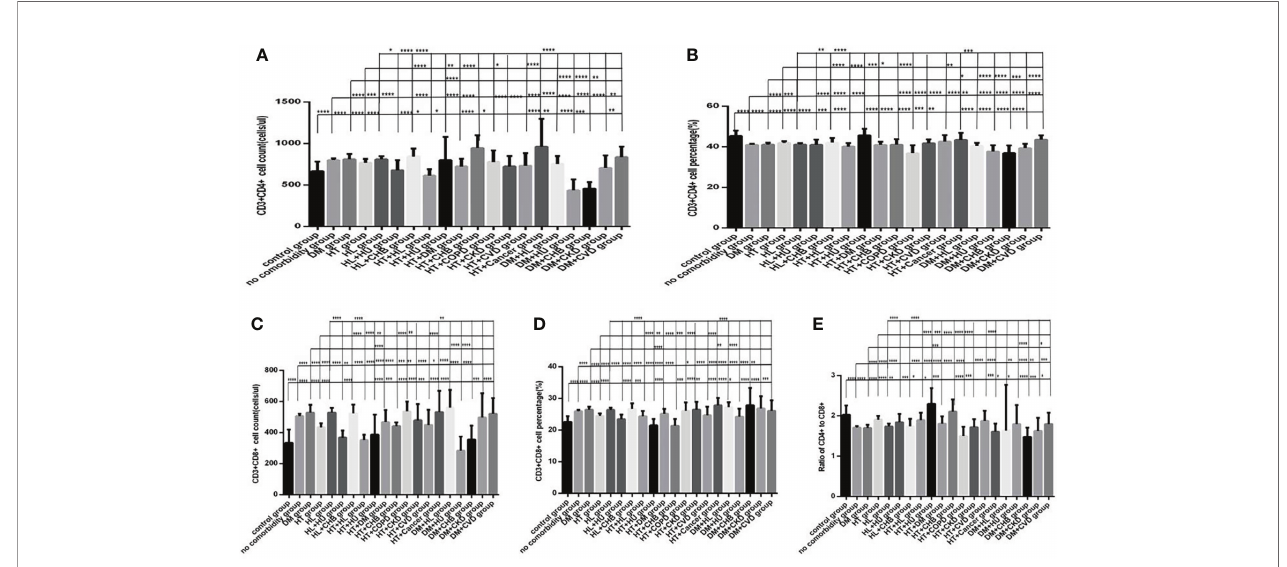
FIGURE 13 | Comparison of T lymphocyte subset counts and percentages among the control group, the no comorbidity group, with DM group, with hypertension group, with hyperlipidemia group, and with each combination of DM, or hypertension, or hyperlipidemia and other comorbidities group( n =773; control, no comorbidity, DM, hypertension, hyperlipidemia and each combination of DM, or hypertension, or hyperlipidemia and other comorbidities group, n =55, 253, 63, 82, 133, 16, 10, 23, 6, 19, 8, 5, 9, 7, 5, 23, 6, 5, 5 and 5 cases, respectively). CHB, chronic hepatitis B.CKD, chronic kidney disease. COPD, chronic obstructive pulmonary disease. COVID-19, coronavirus disease 2019.CVD, cardiovascular disease. NAFLD, nonalcoholic fatty liver disease. DM, diabetes mellitus. HT, Hypertention. HL, heperlipidemia. HU, hyperuricemia and gout. (A) CD3+CD4+ cell count. (B) CD3+CD4+ cell percentage. (C) CD3+CD8+ cell count. (D) CD3+CD8 + cell percentage. (E) Ratio of CD4+/CD8+ cells. Unpaired one-way ANOVA was used for intergroup comparisons ( A – E , P all < 0.0001). Unpaired t -tests were used for comparisons with the control group, and with the no comorbidity group, with DM group, with hypertension group, with hyperlipidemia group, * P < 0.05, ** P <